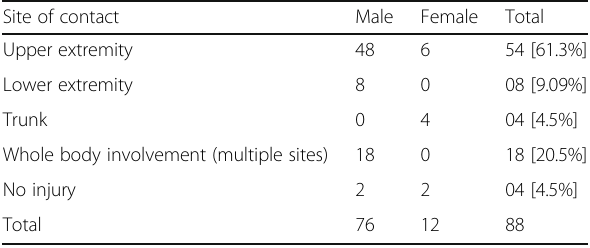
Table 6 Case distribution according to primary contact